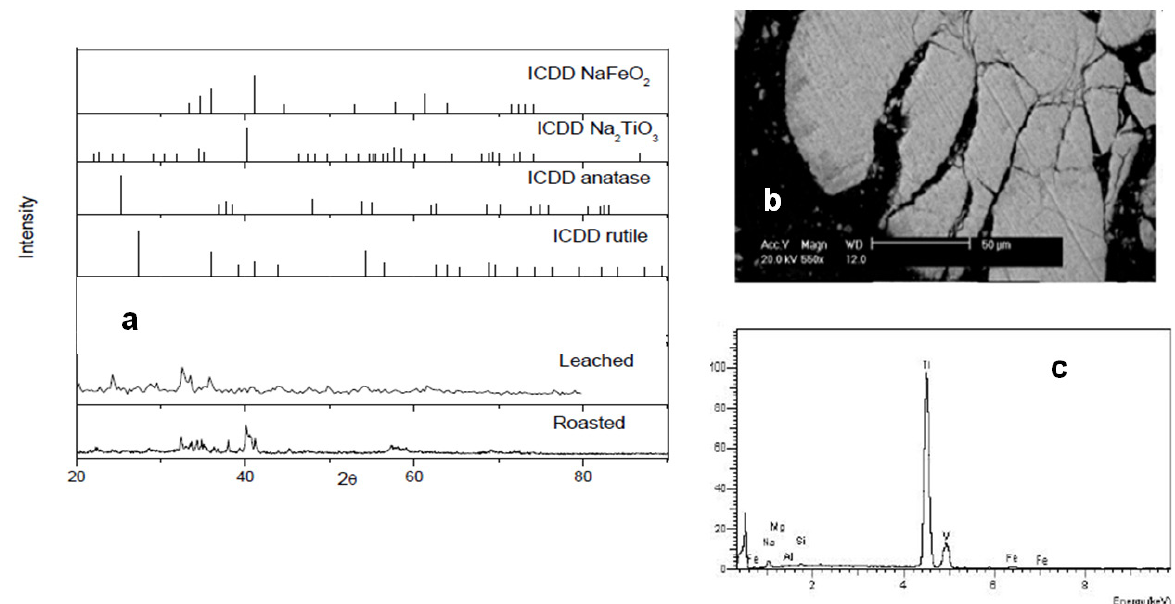
Figure 10: (a) XRPD pattern of organic acids leaching waste; (b) Backscattered image of organic acids leaching waste; (c) EDX of organic acids leaching